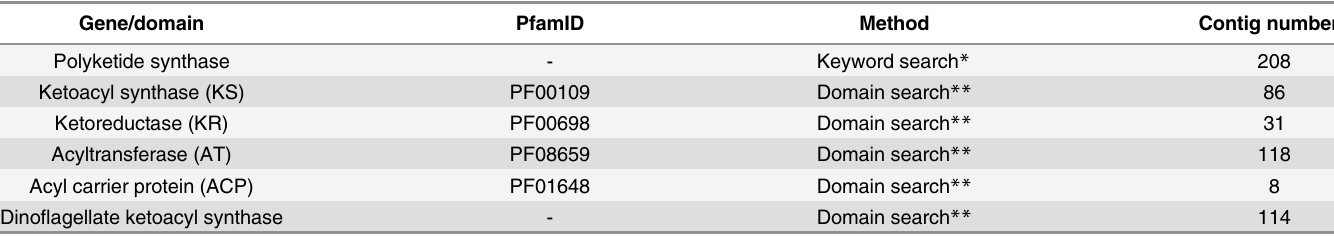
Table 4. Detected contig numbers in PKS genes or PKS domains